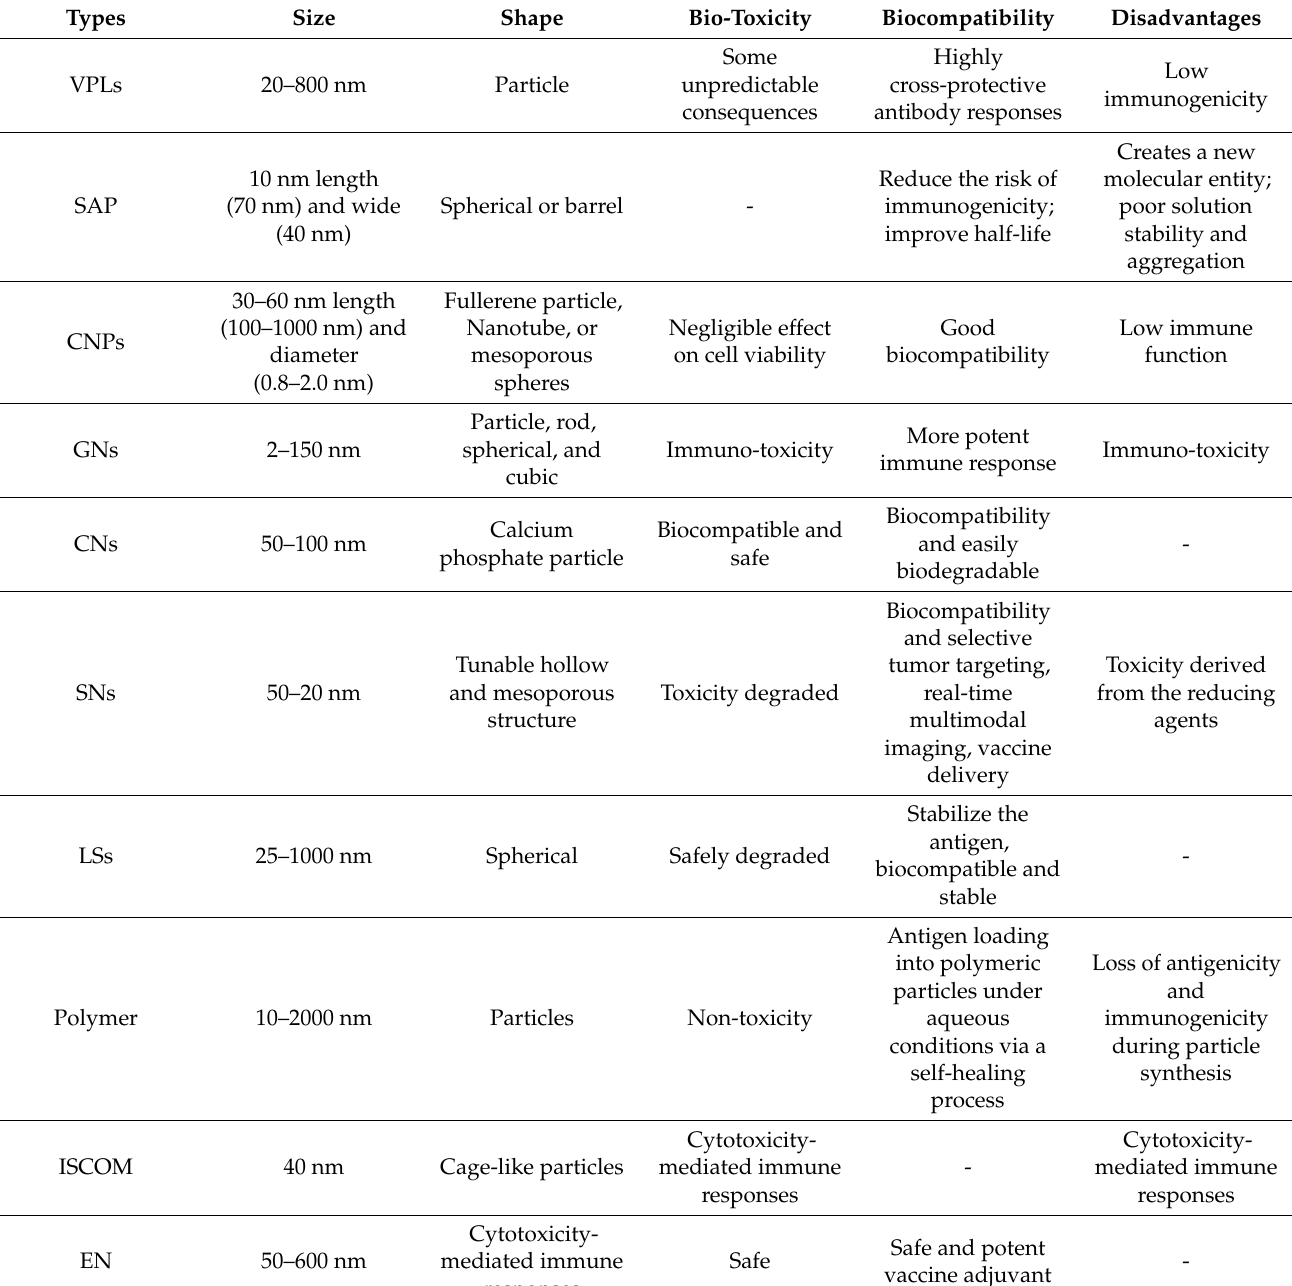
Table 1. Characteristics of different types of nanoparticles used in vaccines. (Adapted from